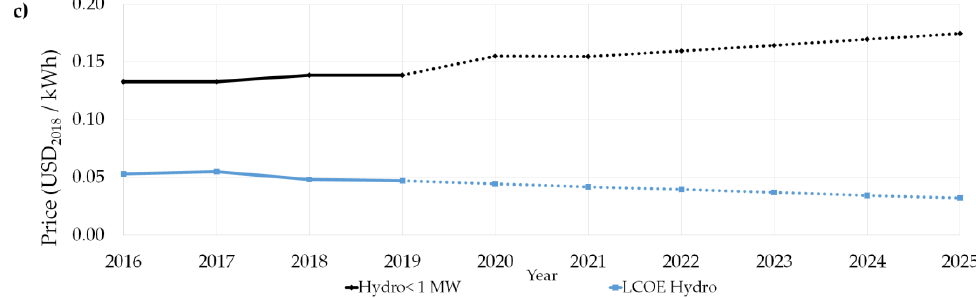
Figure 12. Forecast of reference prices at RES auctions in Poland and LCOE for ( a ) onshore and offshore wind farms, ( b ) PV power plants and ( c ) hydropower plants.